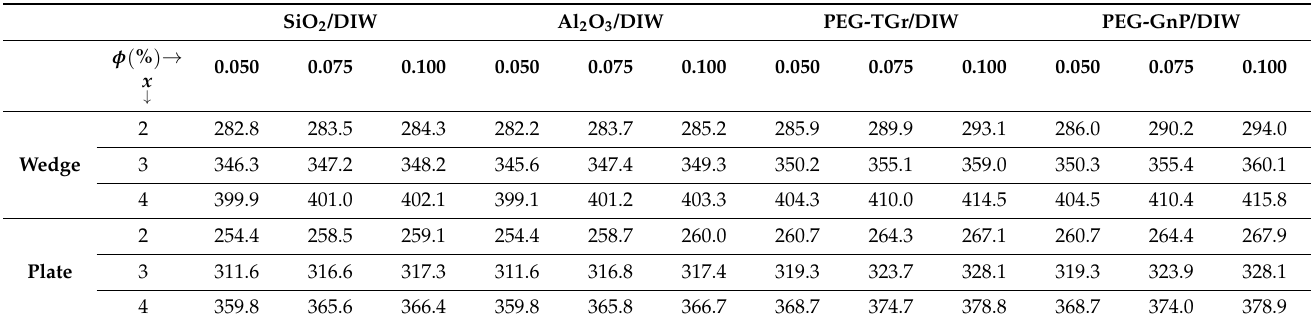
Table 13. Nusselt number Nu x of schematic nanofluids over the wedge and plate at different nanoparticle volume fractions and distinct locations.